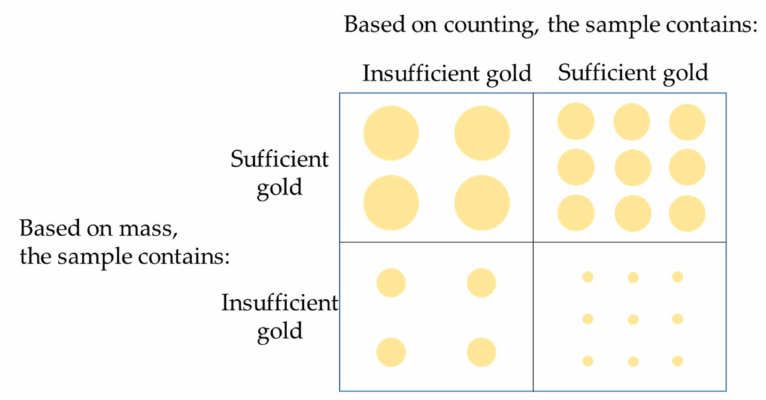
Figure 2. Comparison of sample analysis evaluation based on the mass (proportional number of coarse particles) and total number of particles